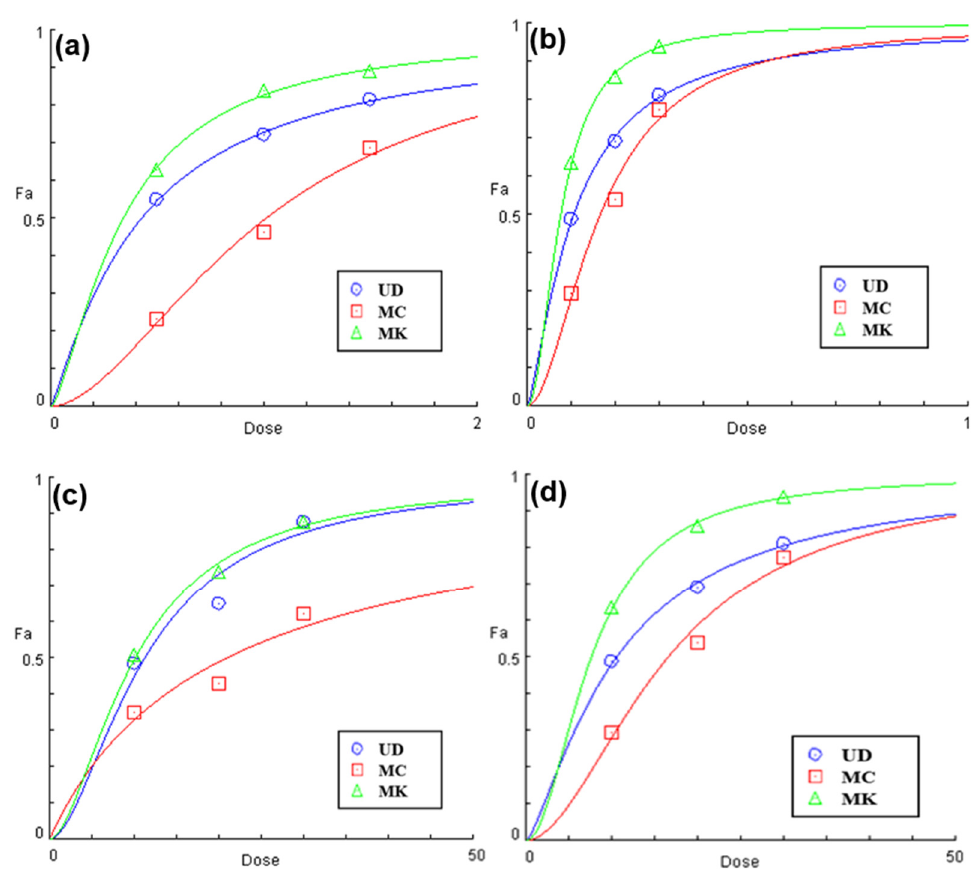
Figure 2. Dose-response profiles of the estimated EC 50 (mg/mL) of ( a , c ) aqueous and ( b , d ) ethanolic extracts of U. dioica (UD), M. chamomilla (MC), and M. koenigii (MK) on the ( a , b ) DPPH and ( c , d ) ABTS assays. Table 2. Estimated EC 50 (mg/mL) of UD, MC, and MK were obtained by different models using DPPH and ABTS assays.